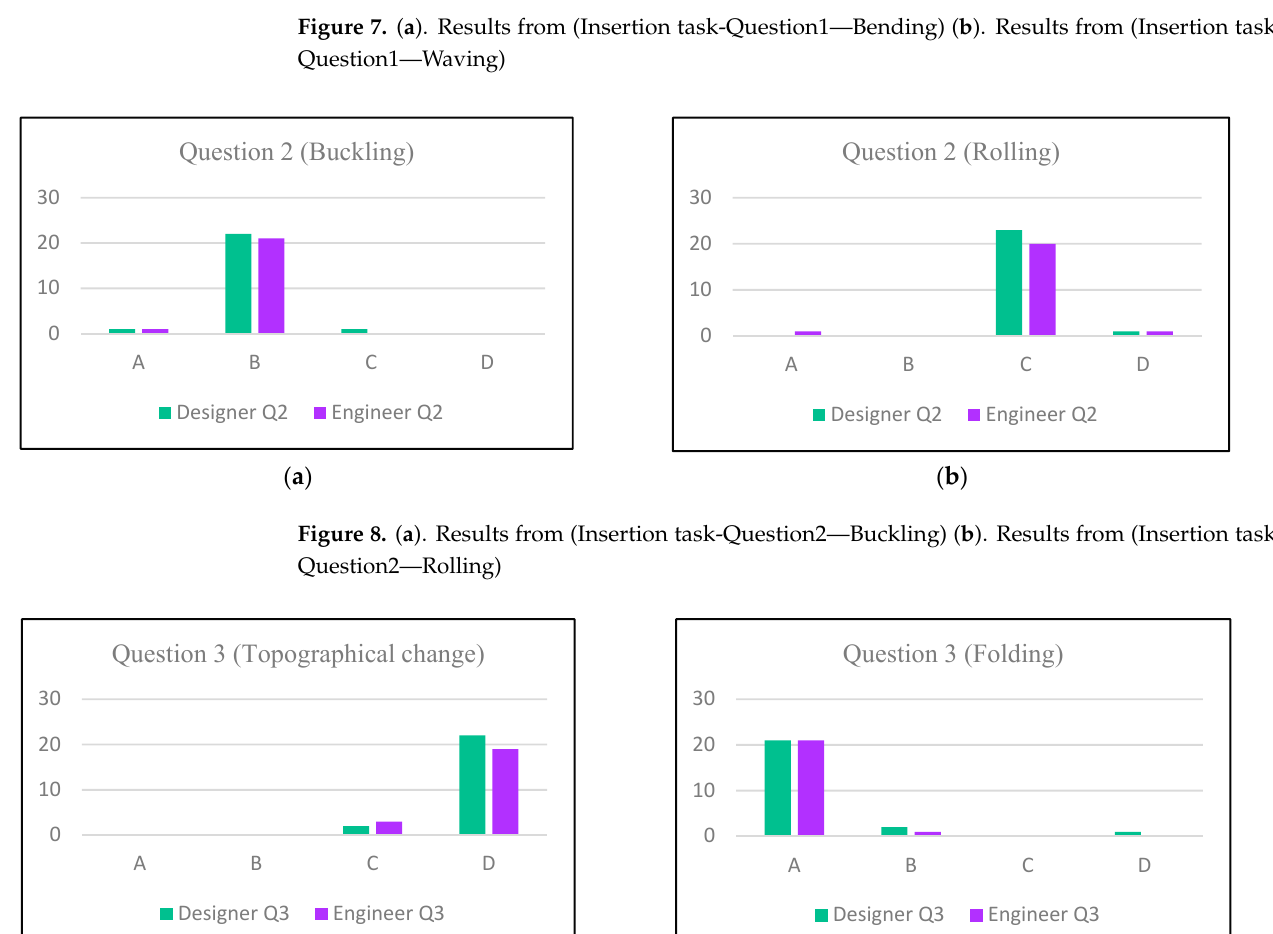
Figure 7. ( a ). Results from (Insertion task- Question1—Bending) ( b ). Results from (Insertion task-